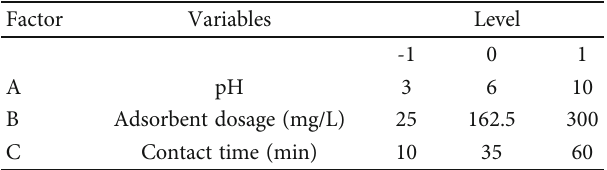
Table 1: Ranges of variables for the design of experiments.